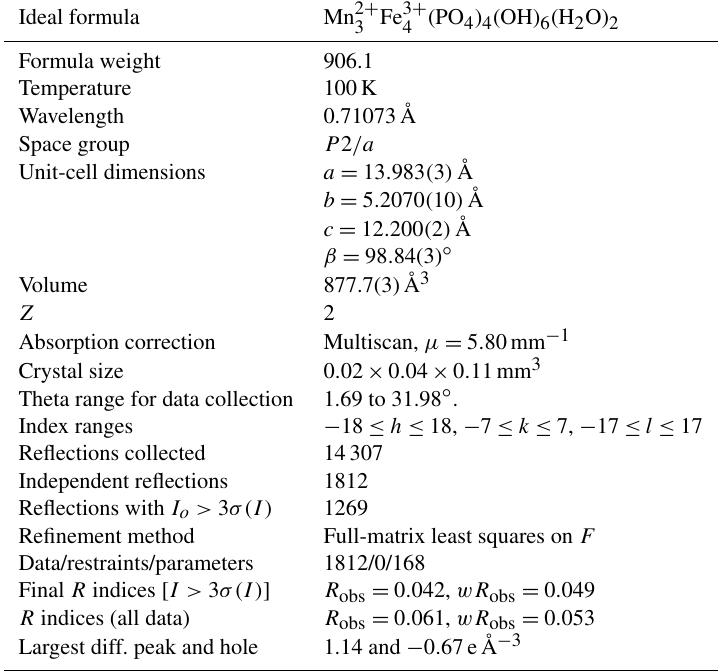
Table 2. Crystal data and structure refinement for kenngottite.